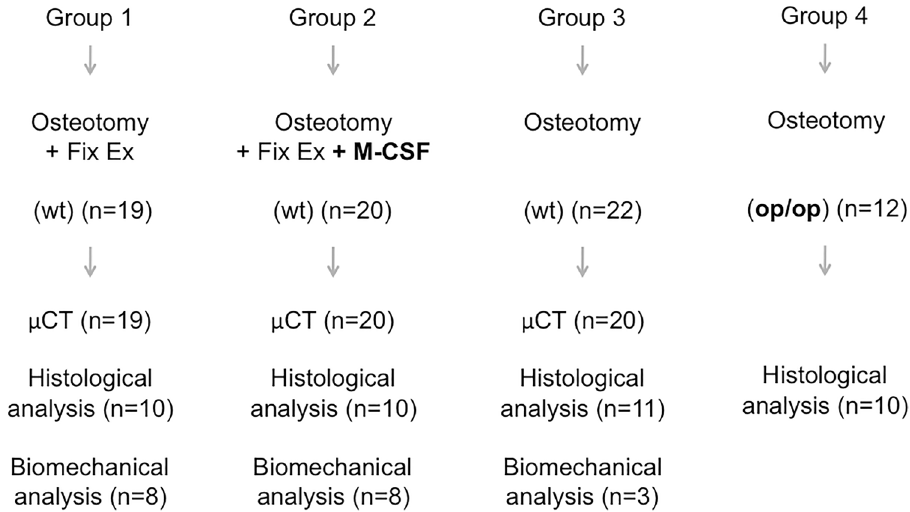
Figure 1. Design of study groups. M-CSF macrophage-colony stimulating factor, wt wildtype, op/op osteopetrosis knock out mice, Fix Ex external fixator, st stabilization.